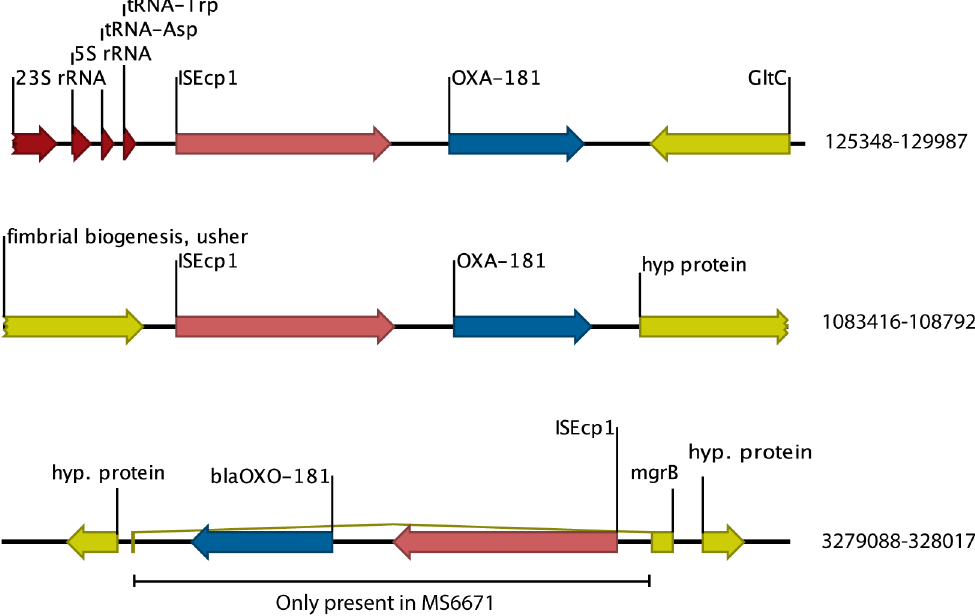
Fig 1. Comparison of blaOXA-181 insertions between DA48896 and MS6671. The OXA-181 readingframe is depicted in blue, the associatedISEcp1 is depicted in red, surrounding proteins coding genesare depicted in yellow and tRNA and rRNA genesin dark red. Positionsindicatedto the right are from the DA48896genome.